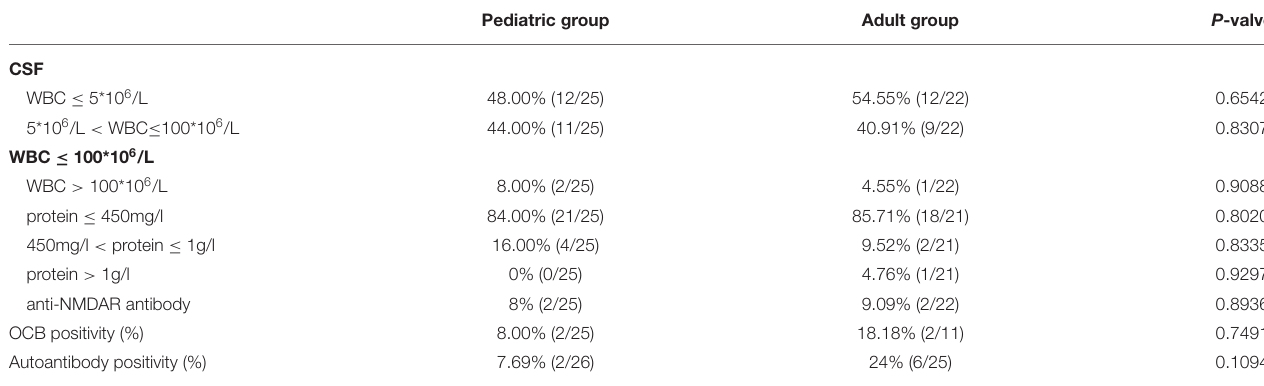
TABLE 2 | Comparison of the laboratory results of the pediatric and adult groups. Pediatric group Adult group P